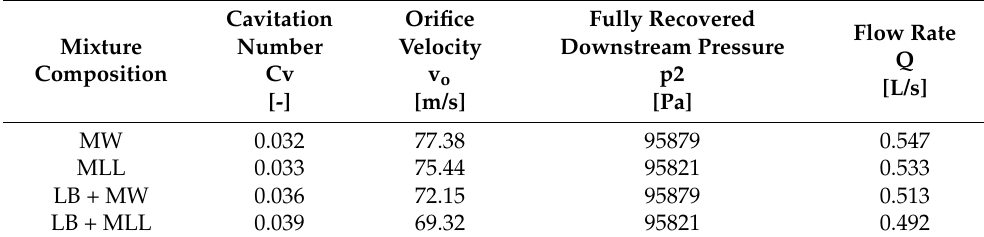
Table 2. The experimental set-up with detailed operational parameters.